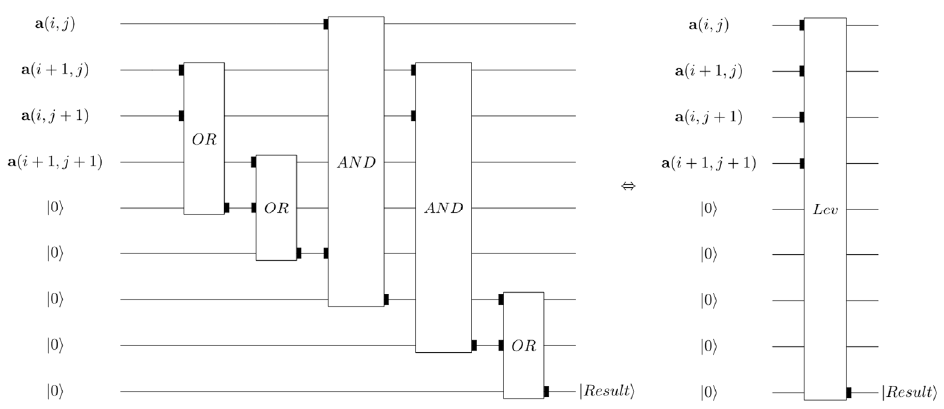
Figure 11. Execution of the Levialdi operator.